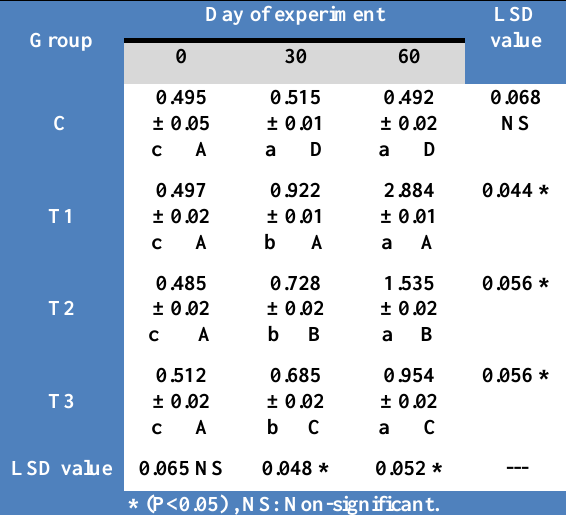
Table, 4: The effect of oral intubation for two months with sodium molybdate, sodium sulfate and their combination on Total Serum Bilirubin (TSB) concentration (mg/dL) of adult male rats. Group